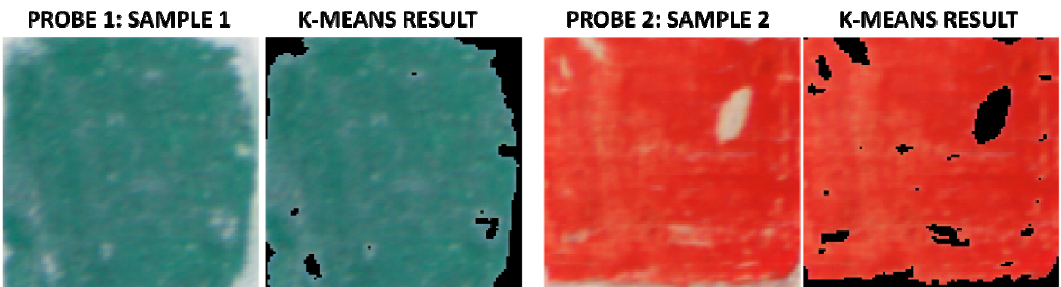
Figure 10. sRGB renderization of cleaned areas and the same with highlighted automatically segmented white areas (black color) of sample 9 in probe 1, and sample 2 in probe 2.